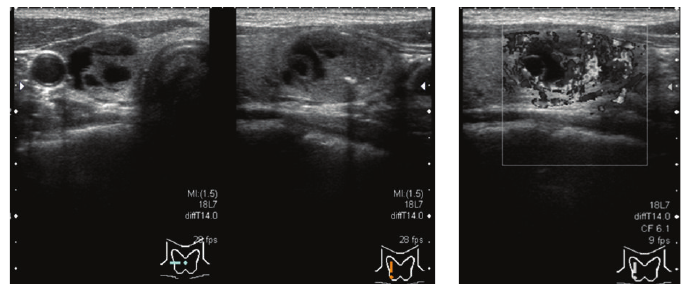
Figure 1: The first echographic examination detected a hypervascular intracystic papillary lesion, which measured 21 × 14 × 10mm and exhibited high echoic spots, in the right lobe.